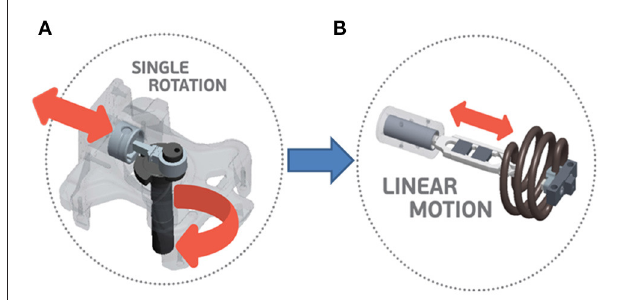
FIGURE 1 | Hermetic compressor designs. (A) Regular. (B) Wisemotion ® .